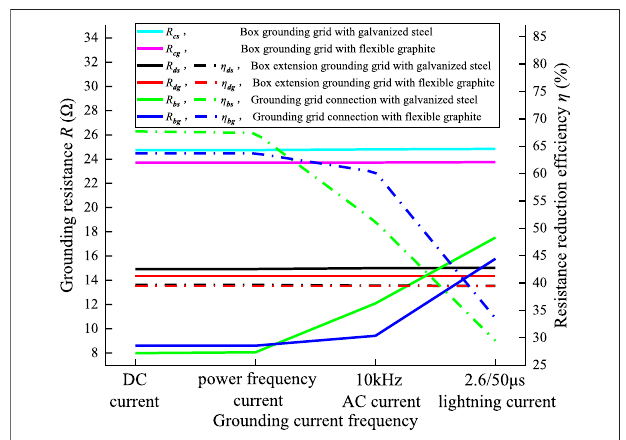
FIGURE 4 | Grounding resistance and resistance reduction ef fi ciency under different grounding current